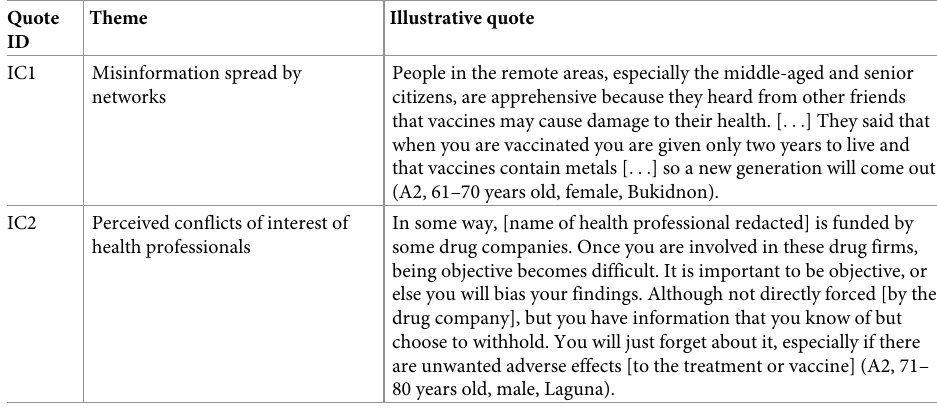
Table 4. Illustrative quotes for interpersonal and community